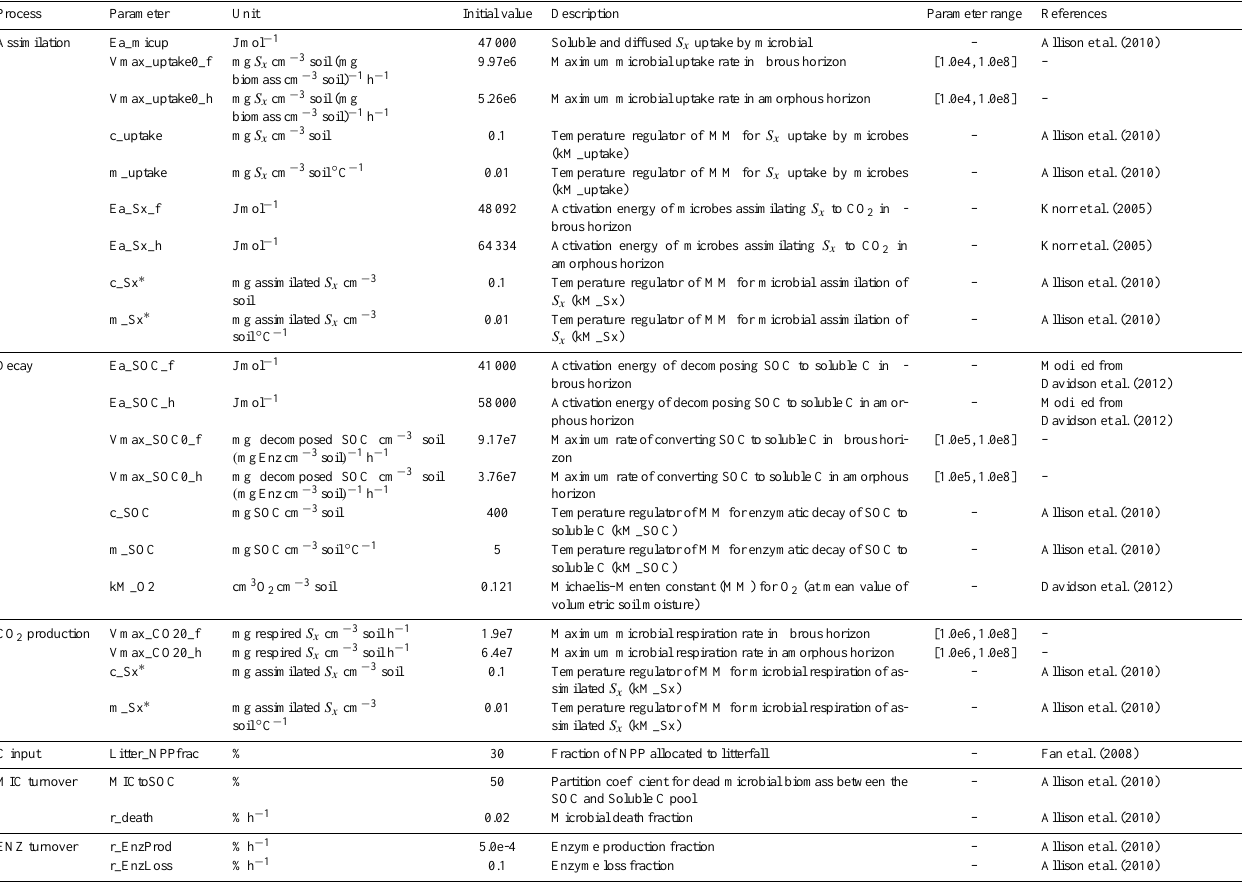
∗ c_Sx and m_Sx are used in both assimilation and CO